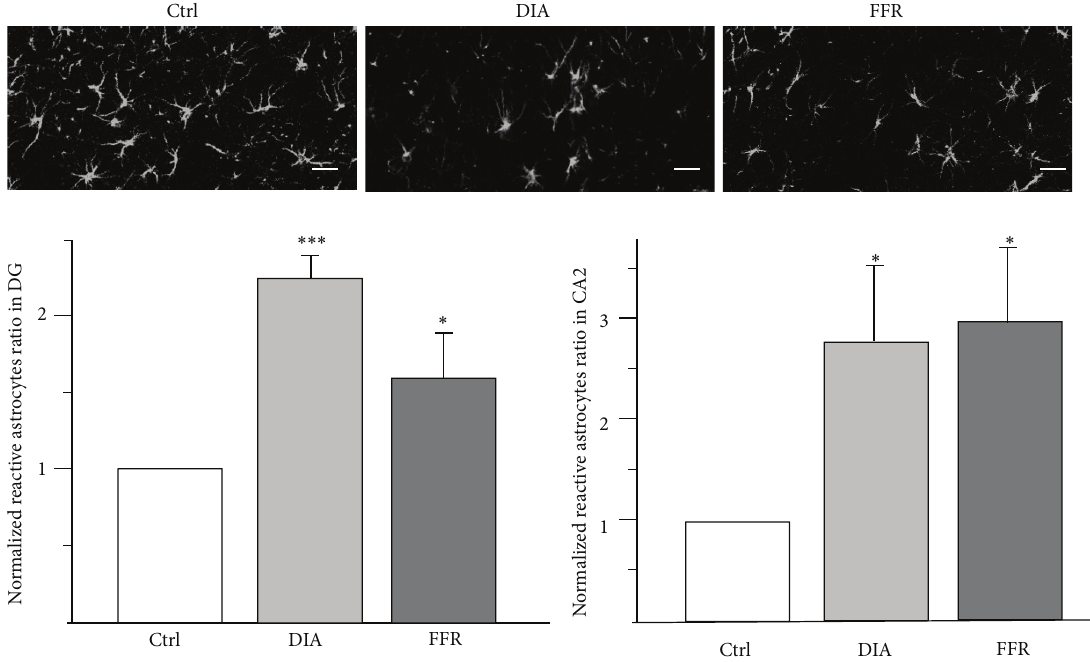
Figure 8: Anorexia increases the density of reactive astrocytes. Representative images of GFAP+ cells in the dentate gyrus (DG) for control (Ctrl), dehydration-induced anorexia (DIA), and forced food restriction (FFR) groups. The density of reactive astrocytes (cells with processes shorter than the diameter of the somata) was estimated for all the experimental groups and normalized with their respective controls for DG and CA2. Data were shown as mean ± SEM. Significant differences were considered as ∗ 𝑝 < 0.05 ; ∗∗∗ 𝑝 < 0.001